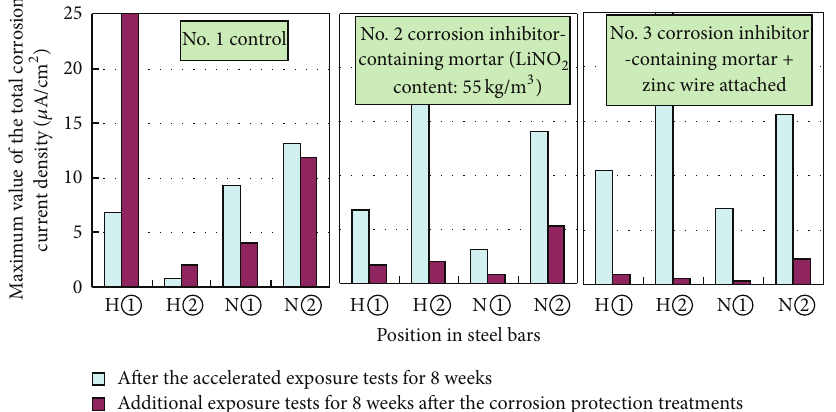
Figure 11: Maximum values of the total corrosion current densities between elements of steel bars before and after the application of LiNO 2 - containing mortar layers and a galvanic